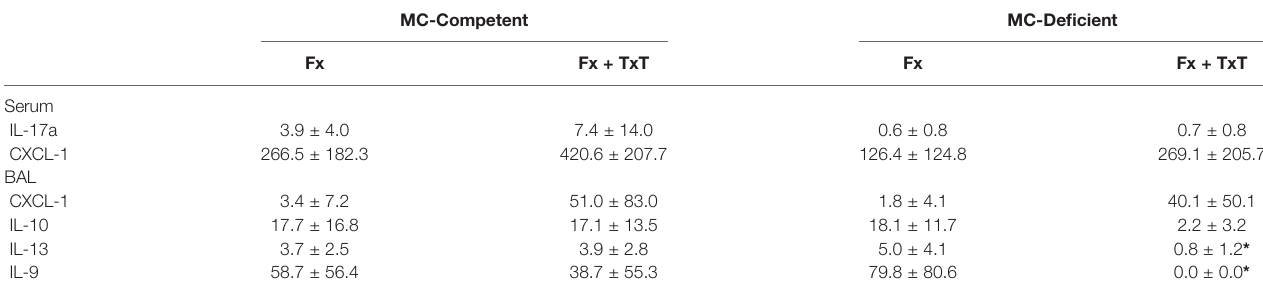
TABLE 1 | In fl ammatory mediator levels in serum and BAL fl uids.